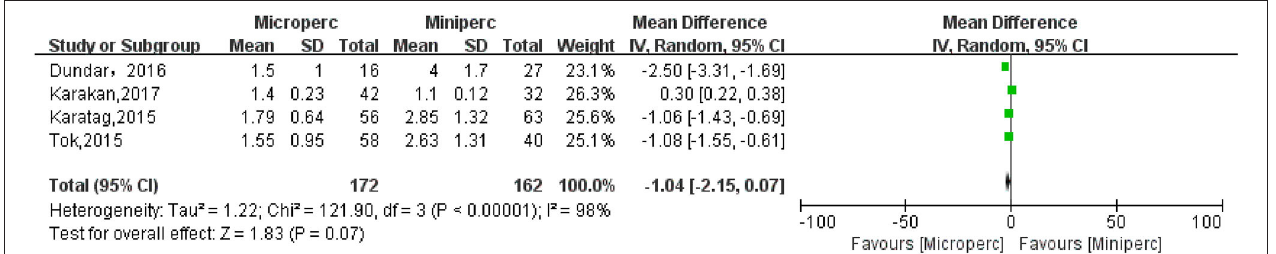
FIGURE 4 | Forest plot for hospital stay